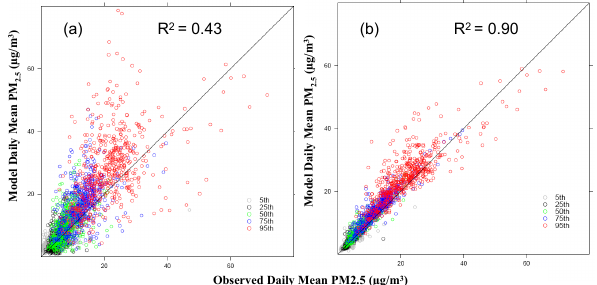
Observed Daily Mean PM2.5 (µg/m 3 ) Fig. 5. Scatterplots between forecasts and observations for Fig. 5. Scatterplots between forecasts and observations for selected selected percentiles for the daily mean PM 2.5 concentrations (µg/m 3 ) for all stations and all days: (a) raw model forecasts, (b) percentiles for the daily mean PM 2 . 5 concentrations (µg/m 3 ) : (a) Kalman fliter-adjusted forecasts. raw model forecasts, (b) Kalman filter-adjusted